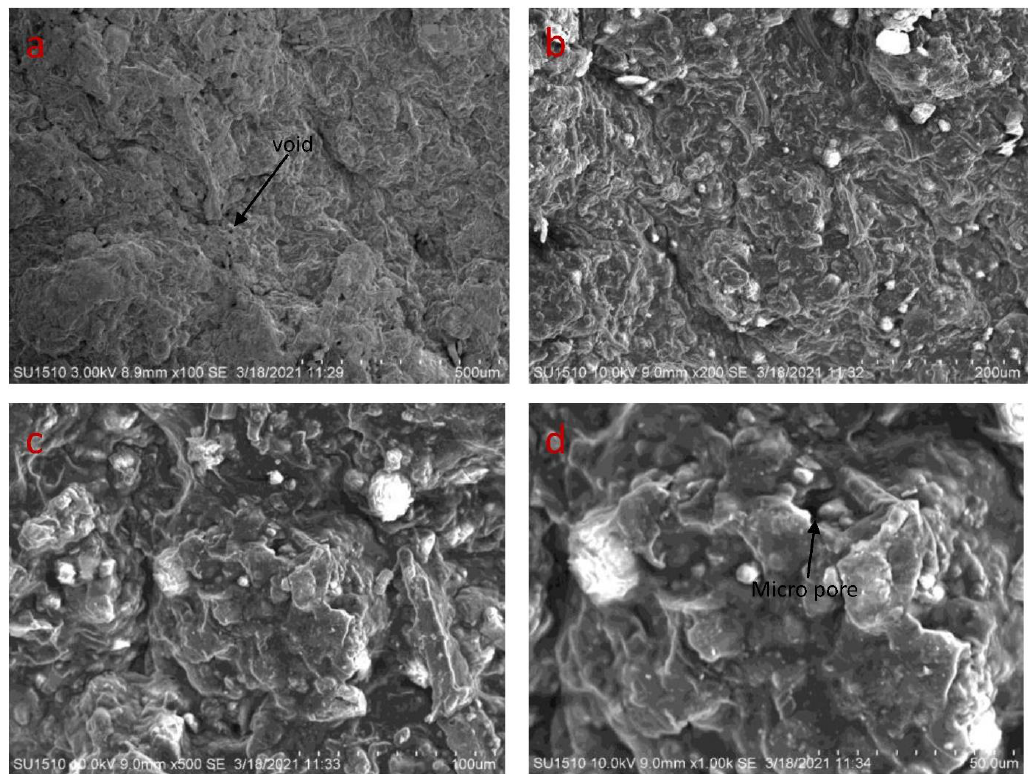
Figure 8. SEM images of 5% fenugreek bio-composite at ( a ) 500 µm ( b ) 200 µm ( c ) 100 µm ( d ) 50 µm.